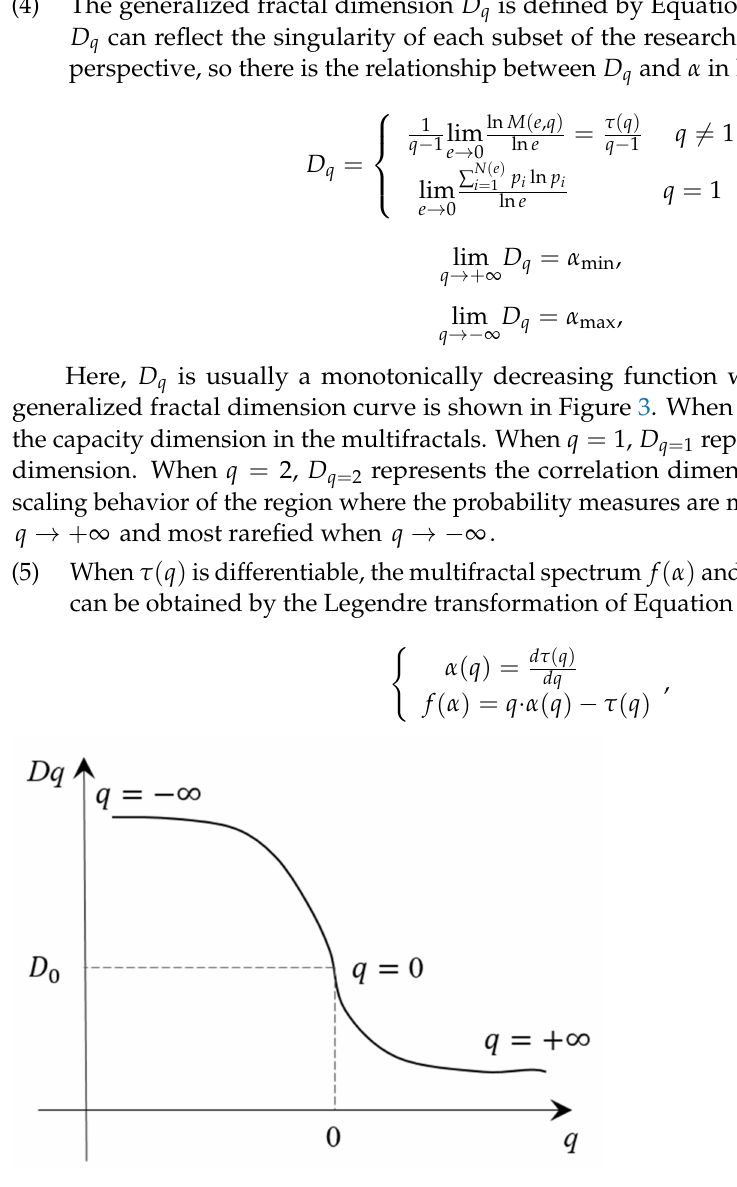
Figure 3. The typical generalized fractal dimension